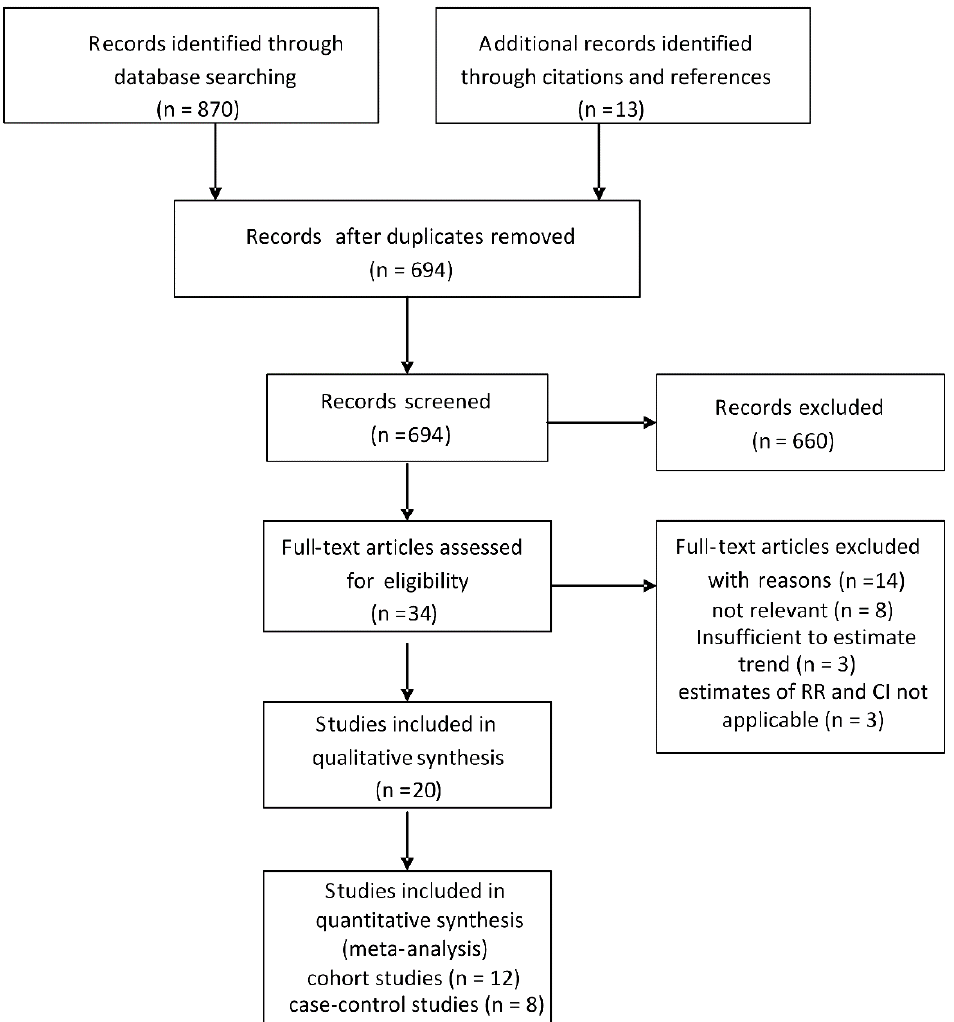
Figure 1. Flow chart of selection of studies included in the meta-analysis.